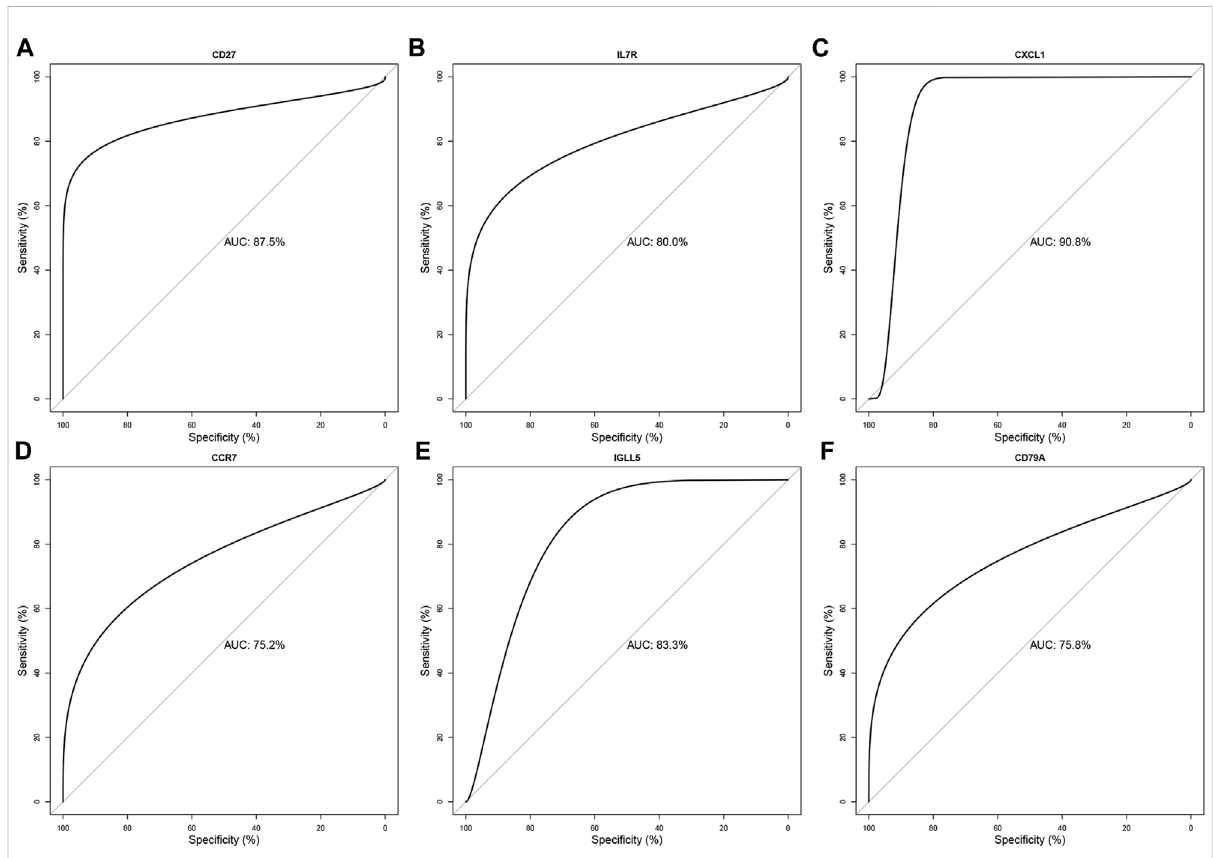
FIGURE 7 Validation of the diagnostic value for the six fi nal hub genes inLOD patients. ROC curve of CD27 , IL7R , CXCL1 , CCR7 , IGLL5 , and CD79A in LOD diagnosis (A – F)